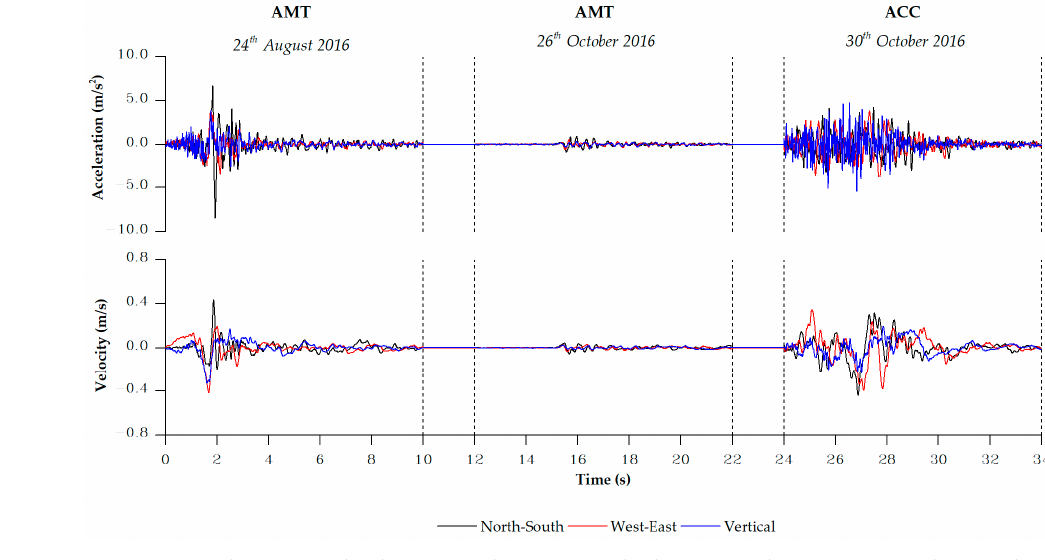
Figure 8. Acceleration and velocity time histories applied to CM and DM, respectively, in order to represent the effect of a seismic sequence.